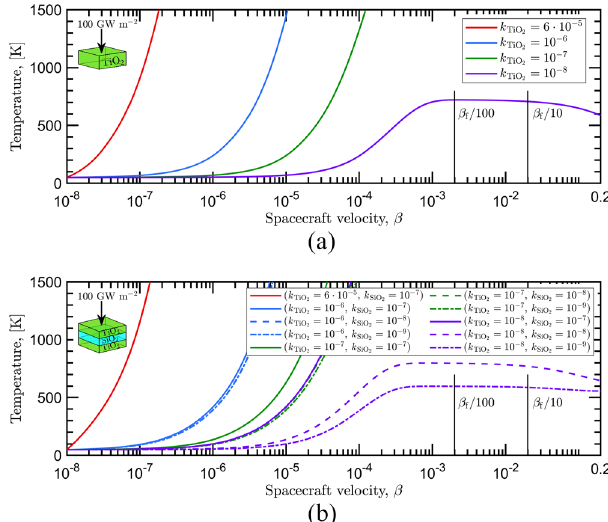
Fig. 9 TiO 2 -based lightsail temperature evolution during the acceleration phase with a laser irradicance I 0 = 100 GW m − 2 . The temperature evolution is calculated for the TiO 2 monolayer ( a ) and for the TiO 2 /SiO 2 / TiO 2 tri-layer ( b ) lightsails for different values of the extinction coef fi cients, given a starting temperature T 0 = 50